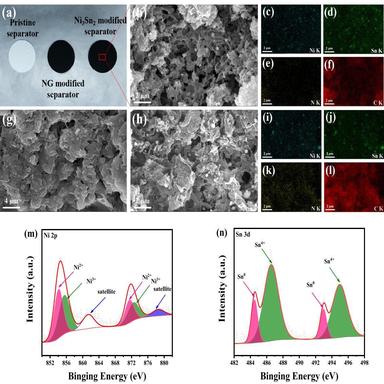
(a) The photographic images of pristine separator, NG modified separator and Ni3Sn2/NG modified separator. (b) SEM image of the Ni3Sn2/NG modified separator. (c-f) The element mappings of the Ni3Sn2/NG modified separator. SEM images of the Ni3Sn2/NG modified separator (g) after 30 cycles at 0.2 C and (h) after 30 cycles at 1C after surface washing. The element mappings (i-l) and high resolution XPS spectra of Ni 2p (m) and Sn 3d (n) of the Ni3Sn2/NG modified separator after surface washing.